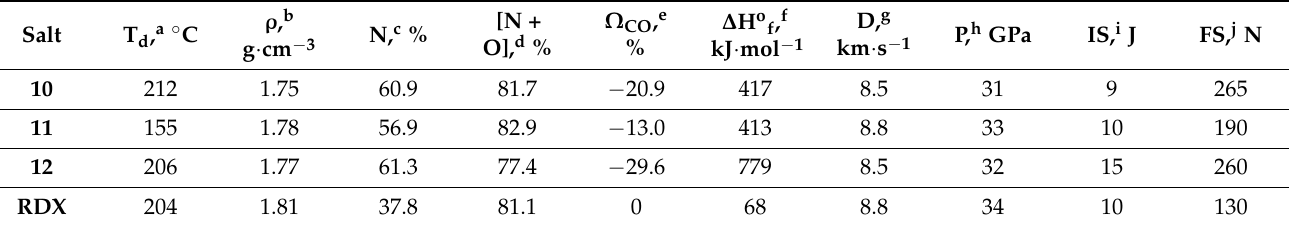
Table 2. Physical properties and detonation parameters of salts 10 – 12